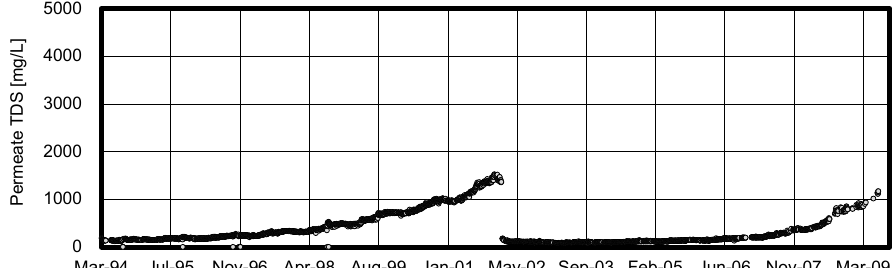
Figure 17. Seawater RO desalination in Jeddah 1 phase II plant. Data from [94]. Table 1. Comparison of 35% and 40% recovery ratio operation in Jeddah RO-2 plant. The Ras Al Khair SWRO plant (capacity of the first pass: 899 m 3 /h × 16/train × 24 h =